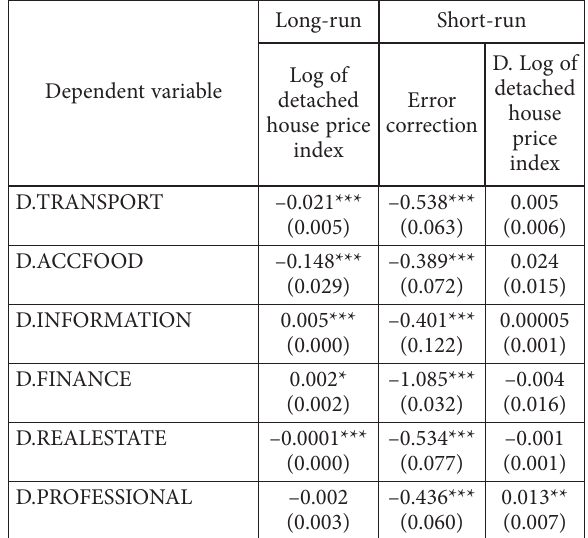
Table 5. Terraced house price index and sub-sectoral